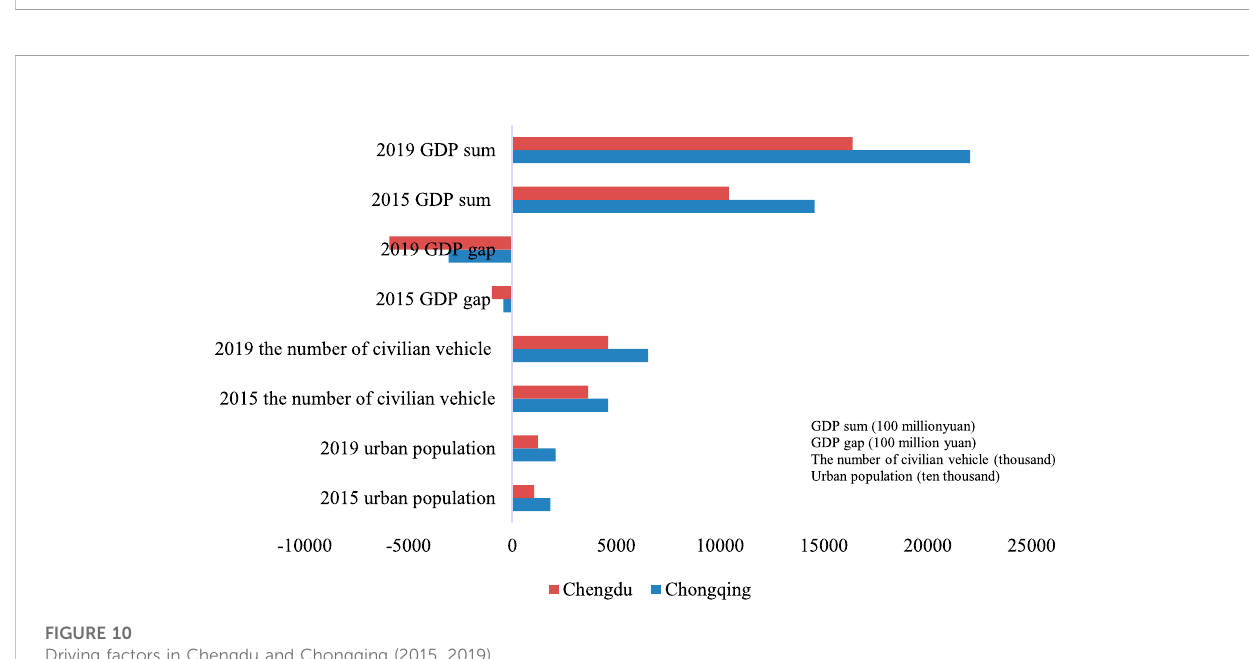
FIGURE 9 The relationship of driving factors and PM 2.5 in the SCB (2015, 2019). (A) Driving factors and city with PM 2.5 < 35.00 μ g/m 3 in Figure 2A in 2015 (B) Driving factors and city with PM 2.5 < 35.00 μ g/m 3 in Figure 2E in